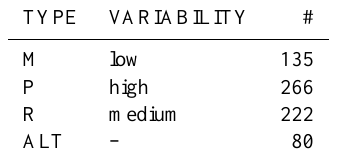
Table 6. Number of stations (in %) for which the mean bias after analysis is reduced, the mean bias calculated as in Table 4. The total number of sites for each type is indicated in the first